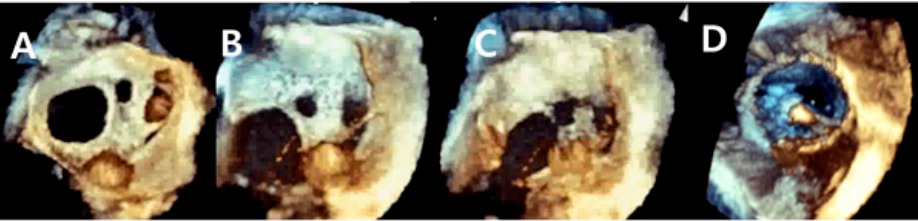
Figure 2. Real-time three-dimensional transesophageal echocardiography images during transcatheter closure of multiple atrial septal defects. ( A ) The defect is seen here, and its size, shape, and distance from the surrounding structures are clearly noted. The posterior and inferior septal rims are poorly visualized. ( B , C ) The guide catheter is visible across the atrial septum. ( D ) This photograph shows left disk expansion and stable positioning of the three septal defect closure devices.